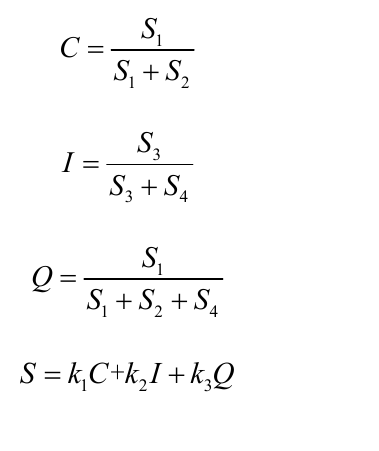
Figure 12. Result of image processing, (a) Original image with defect, (b) Result of this paper, (c) Result of maximum entropy, (d) Result of minimum